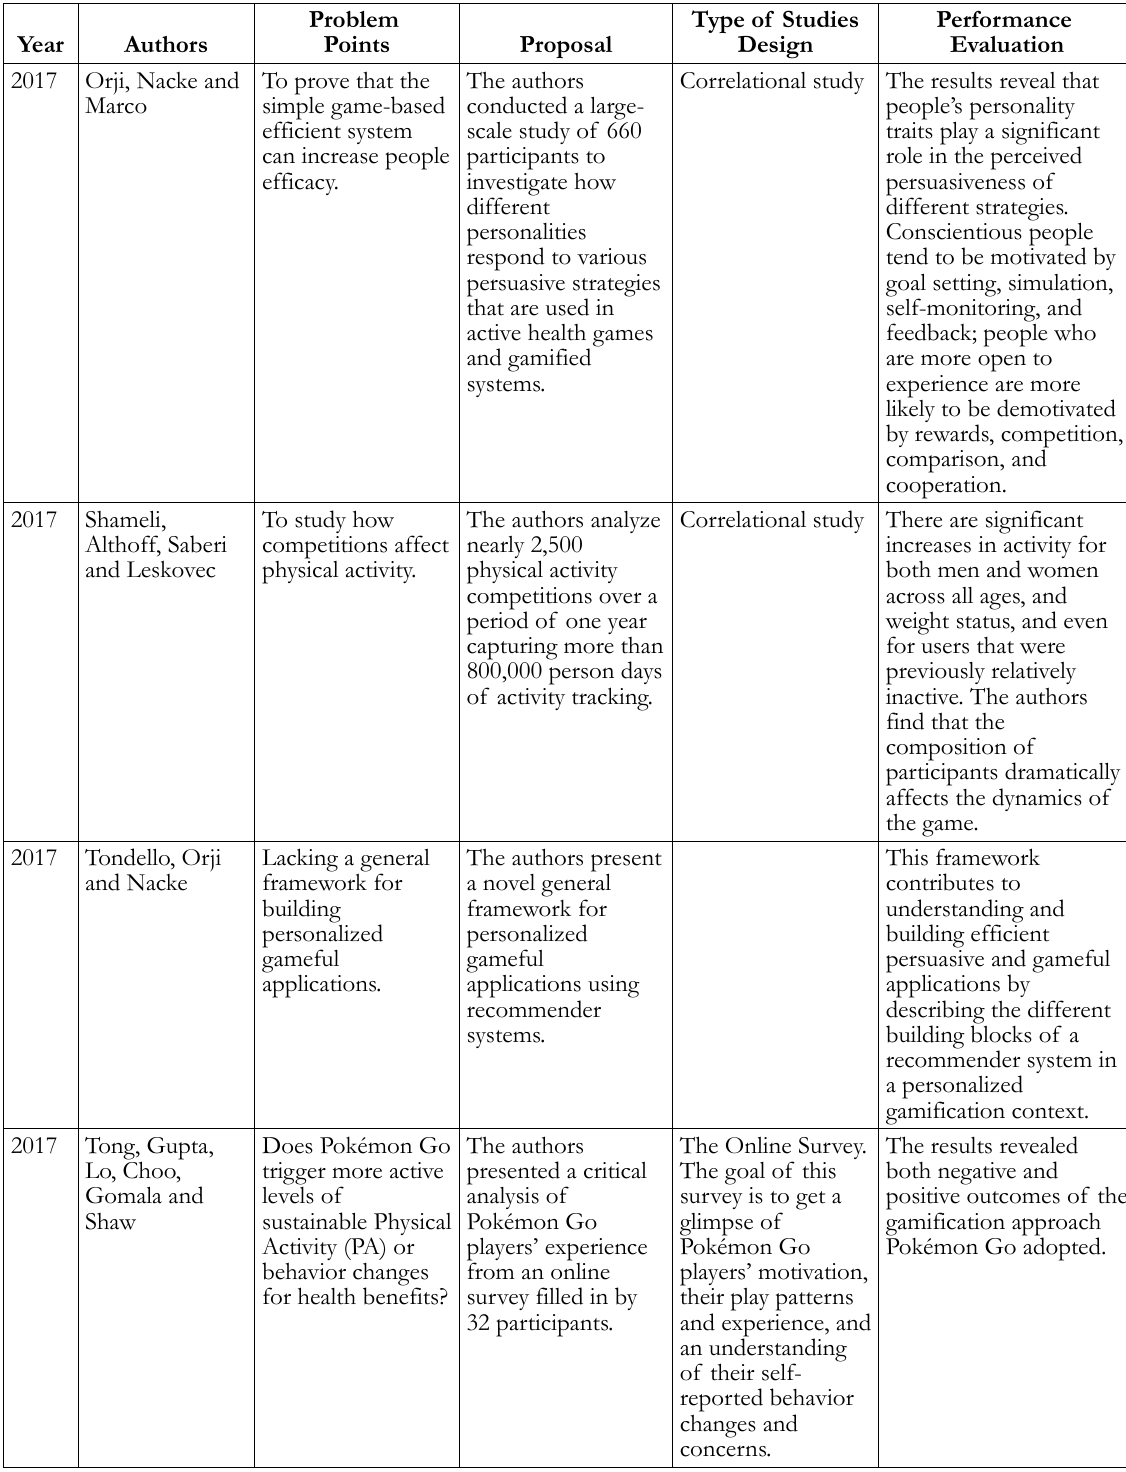
Table 2. Summary of the extract data from the selected papers